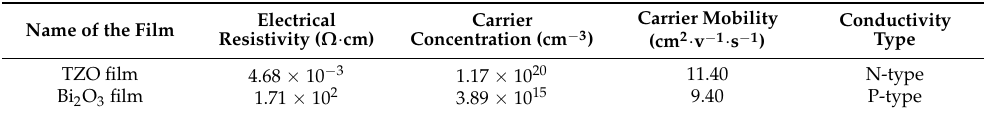
Table 5. Hall effect measurements for TZO and Bi 2 O 3 films.